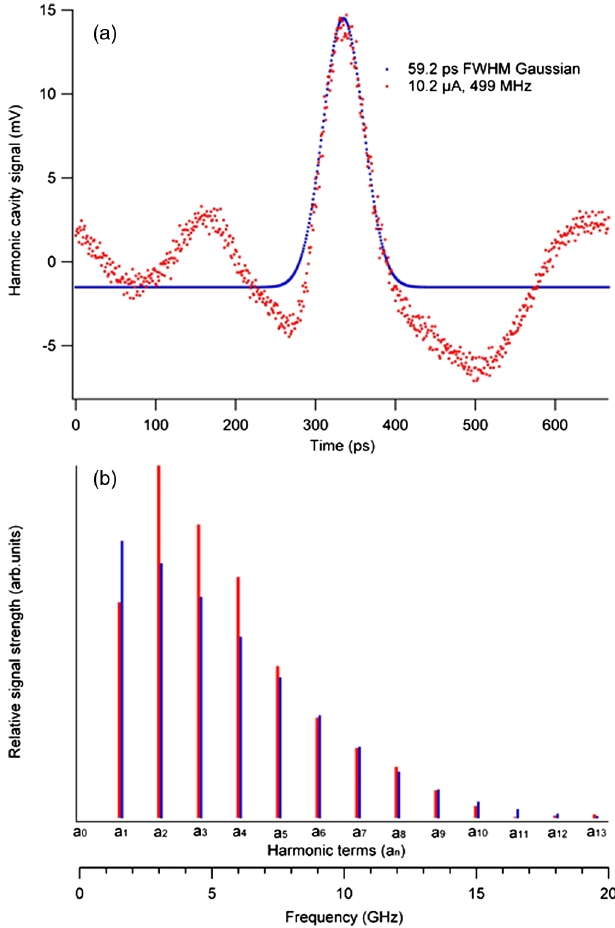
FIG. 4. (a) the raw oscilloscope trace for 10 μ A beam through the harmonically resonant cavity at 499 MHz repetition rate (red) and the assumed bunch profile that provided a transfer function that produced transformed oscilloscope waveforms with the minimum signal outside the central bunch (blue), (b) the relative signal strength for each resonant mode of the harmonically resonant cavity: red, cavity as measured, and blue, the response of an ideal harmonic cavity.